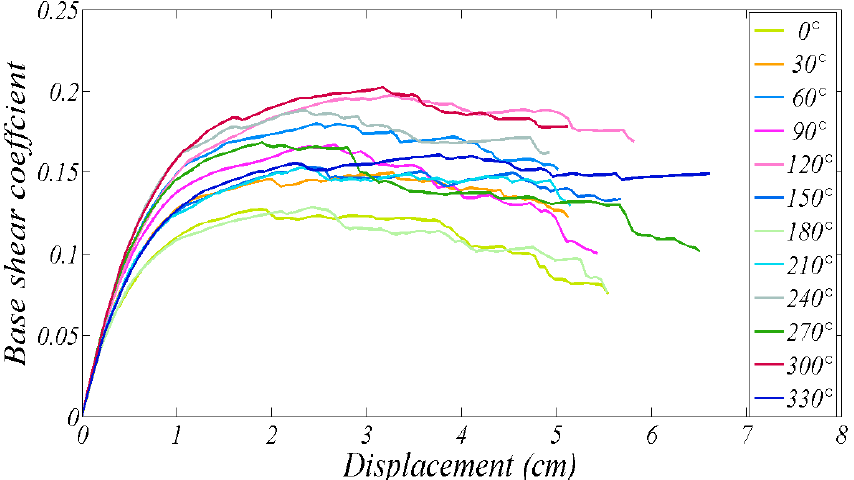
Figure 13. Capacity curves summary.